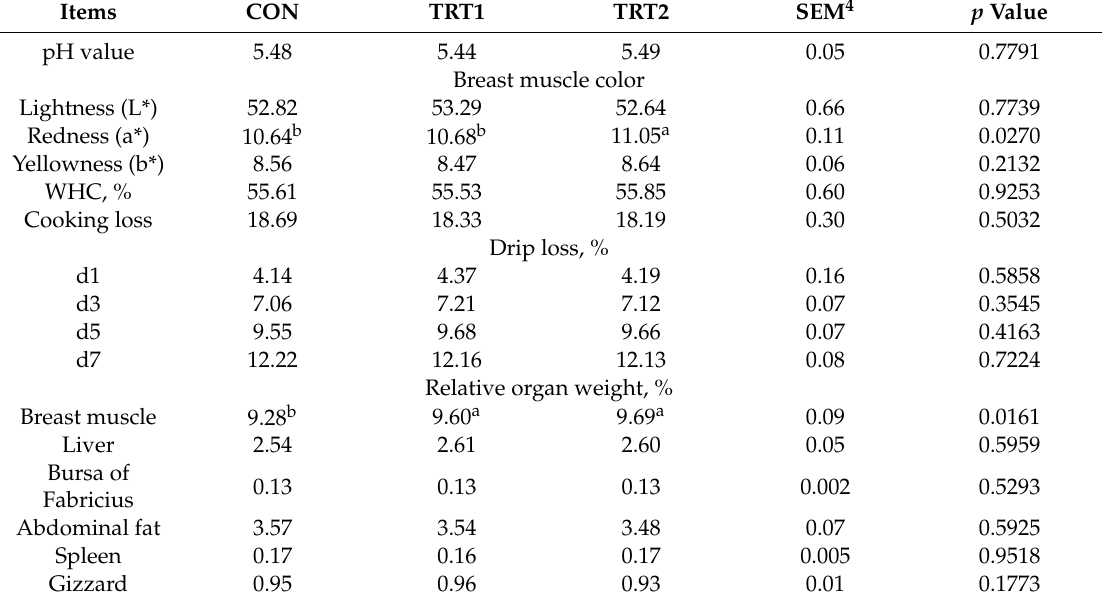
Table 6. The e ff ect of dietary DOL supplementation on meat quality in broilers † , ‡ . Items pH value